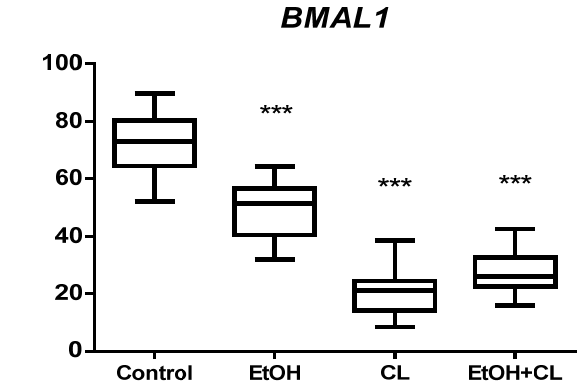
Figure 7. Levels of BMAL1 expression in hepatocytes of rats. *** ( p ≤ 0.0005)—in comparison with the parameters of animals of the control group.